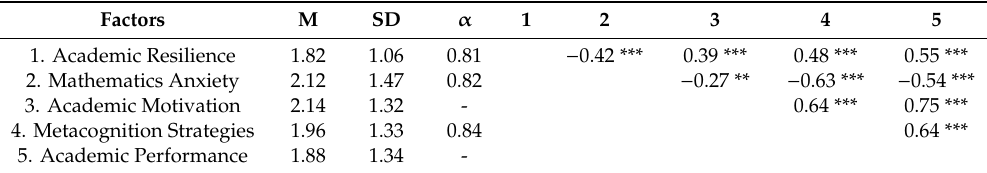
Table 1. Mean, standard deviation, analysis of internal consistency and bivariate